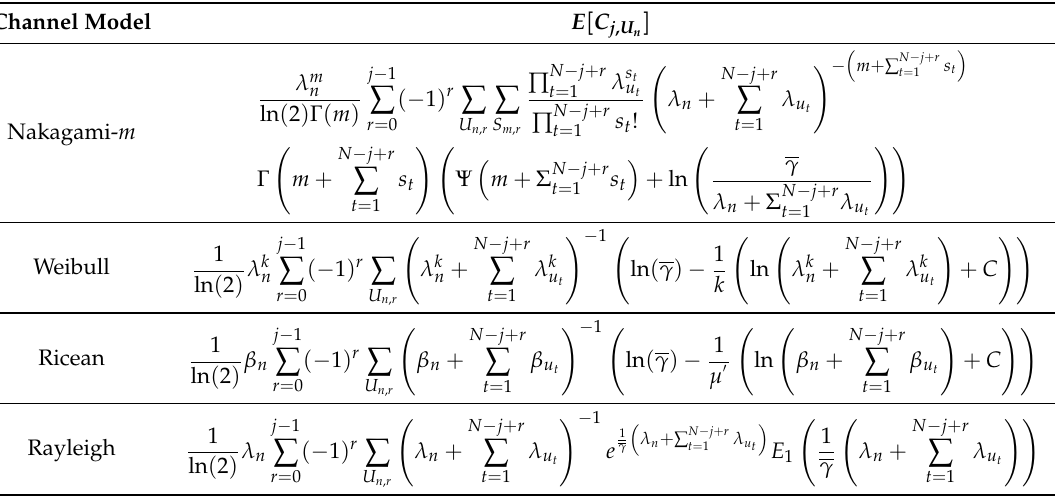
Table 4. ECC of single user obtained by IS2M.